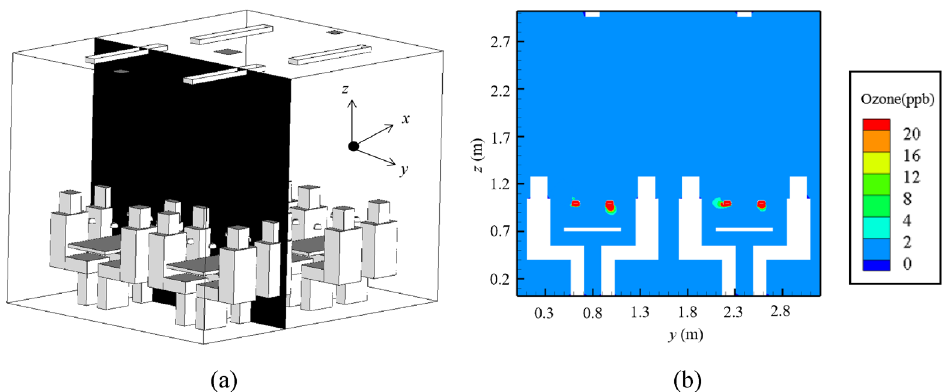
Figure 8. Elevated ozone concentration after the far-UVC lamps were switched on: ( a ) position of the plane of interest to show the ozone concentration; ( b ) concentration contour on this